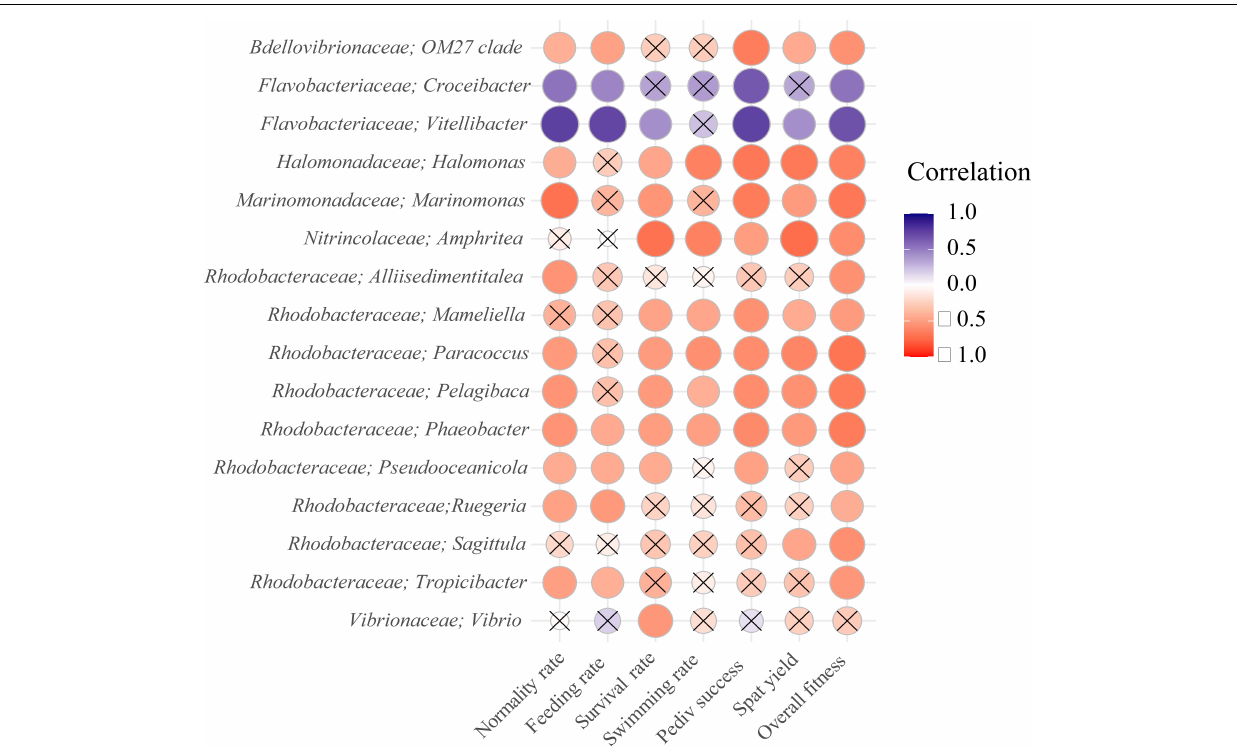
Frontiers in Microbiology |